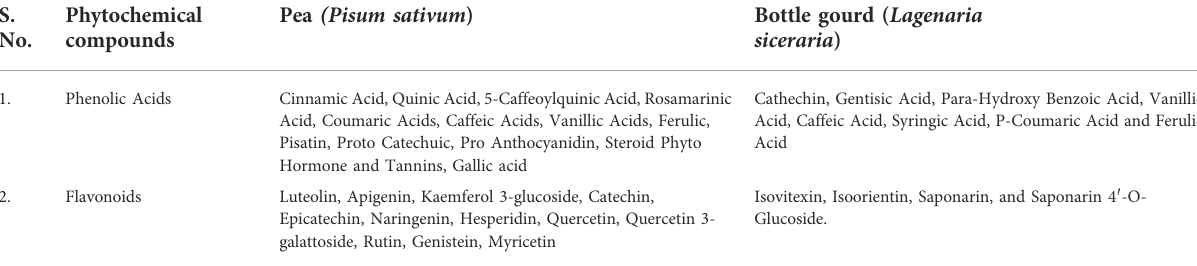
TABLE 3 Phenolic acid and fl avonoid content in the pea ( Pisum sativum) and bottle gourd ( Lagenaria siceraria ) (Kumar et al., 2015; Obembe et al., 2018; Castaldo et al., 2021; Naqvi et al., 2021). S.